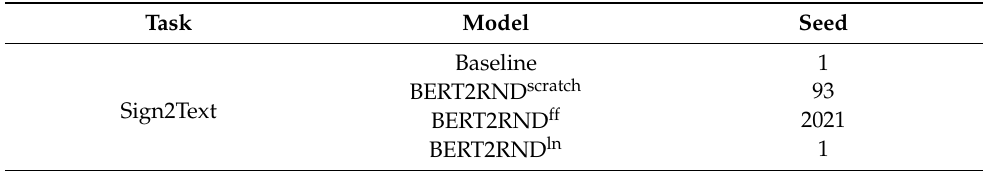
Table A1. Random seeds resulting in the model with median BLEU-4 score, for every model-task